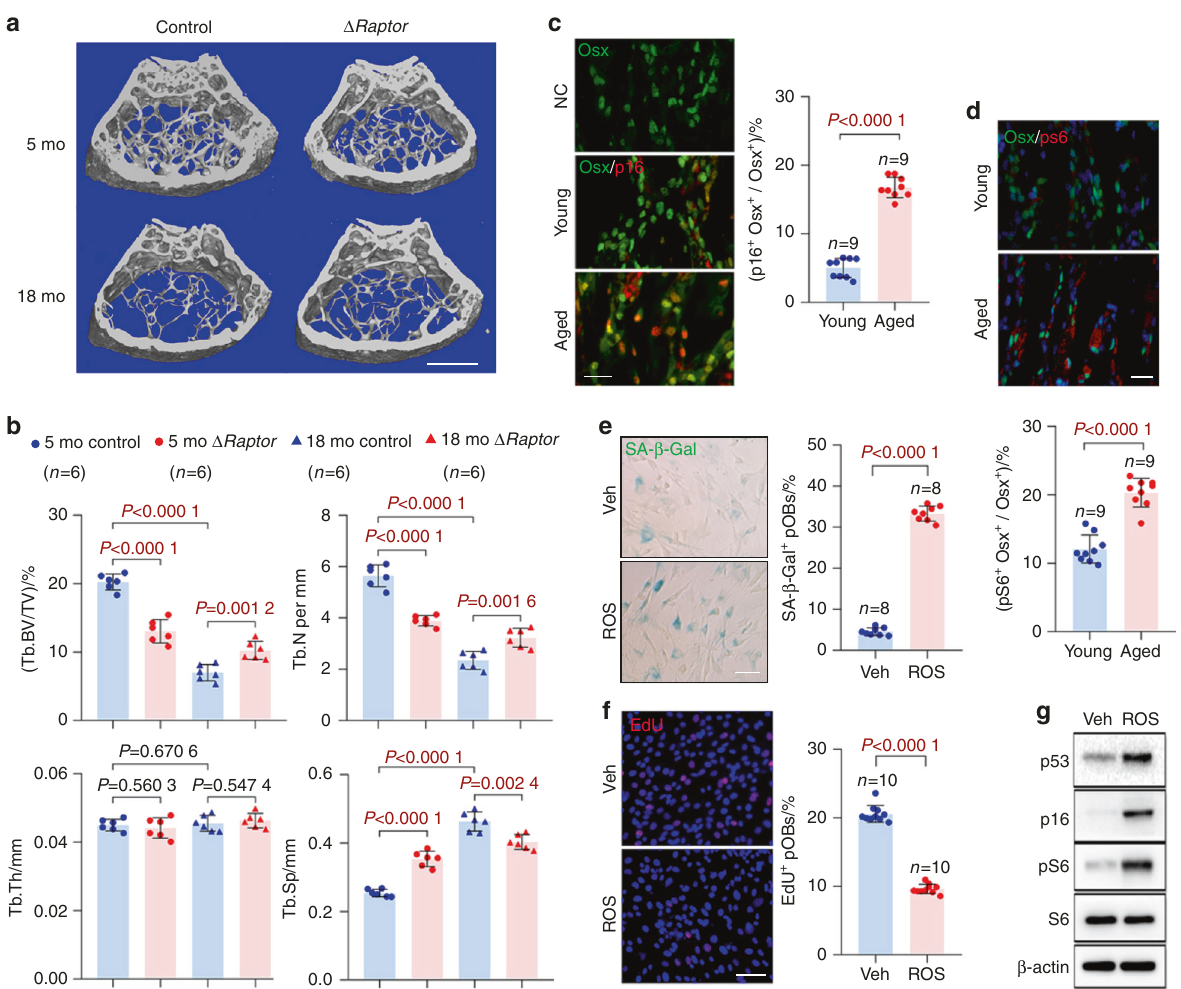
Fig. 1 Senescent preosteoblasts present elevated mTORC1 activity. a Representative microcomputed tomography ( μ CT) images of femurs of 5-month-old (mo) and 18-month-old (mo) Δ Raptor mice compared with those of the littermate controls. Scale bar: 500 μ m. b Quanti fi cation of trabecular bone volume per total volume (Tb.BV/TV), trabecular number (Tb.N), trabecular separation (Tb.Sp) and trabecular thickness (Tb.Th). Representative images of double immunostaining of Osx plus p16 ( c ) and Osx plus pS6 (Ser235/236) ( d ) in the bones of the mice in a . Single Osx staining served as a negative control (NC) for double staining of Osx plus p16 in c . Scale bars: 100 μ m. e The murine preosteoblast cell line MC3T3-E1 was exposed to senescence induction by reactive oxygen species (ROS) or treated with vehicle (Veh) and stained for the expression of senescence-associated β -galactosidase (SA- β -gal) 3 days later. Scale bar: 50 μ m. Quanti fi cation of the proportion of SA- β -gal + preosteoblasts (pOBs) in each population is shown. f Representative confocal images of immunostaining of EdU (red) in the cells in e and quantitative analysis of EdU + pOBs relative to total cells (%). Scale bar, 100 μ m. g Western blot analysis of senescence marker (p16 and p53) expression and mTORC1 activity [pS6(Ser235/236)] in the cells in e . Data are shown as the mean ± SD. The numbers of samples ( n ) are indicated in each fi gure panel. P values were determined by two-tailed Student ’ s t test for single